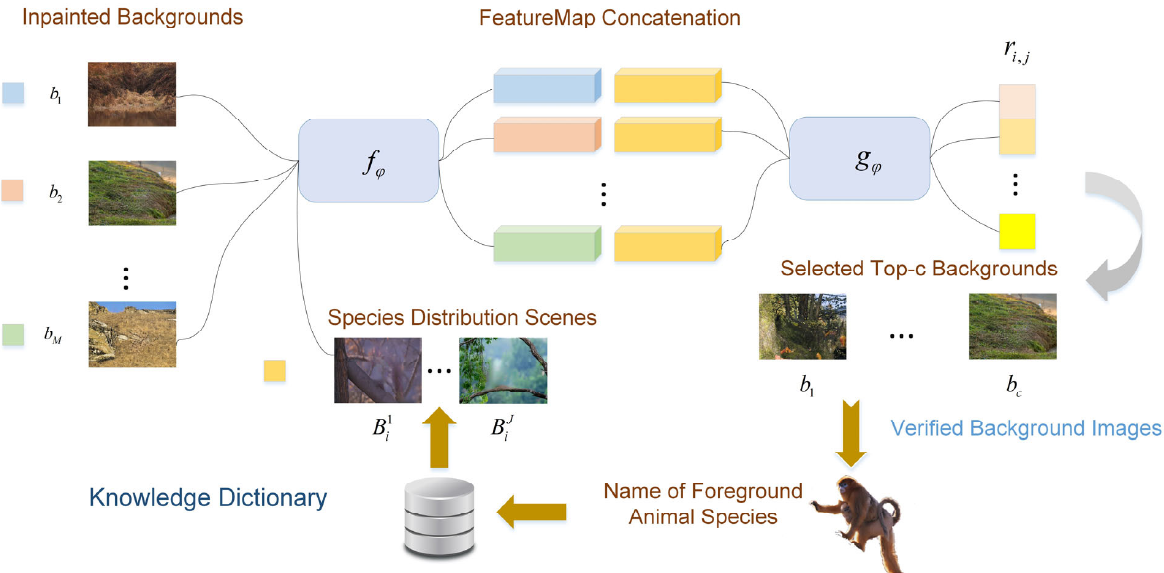
Figure 3. Architecture for the selected top-c backgrounds with knowledge dictionary and relation network. The goal is to automatically detect the relevance of the inpainted background images and species by measuring the image similarity. Note that all pictures do not assign geographic coordinates because images in the dataset often do not have geotags. While we have not chosen geotagged photos, this framework allows us to develop more general models.